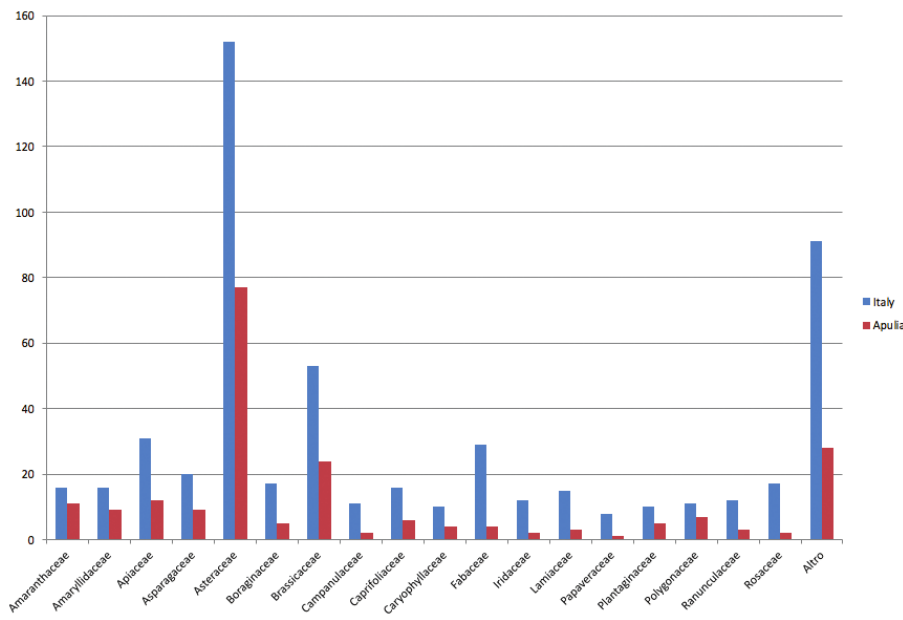
Figure 4. Comparison among families of wild species used in Italy (blue) and in Apulia (red) by number.